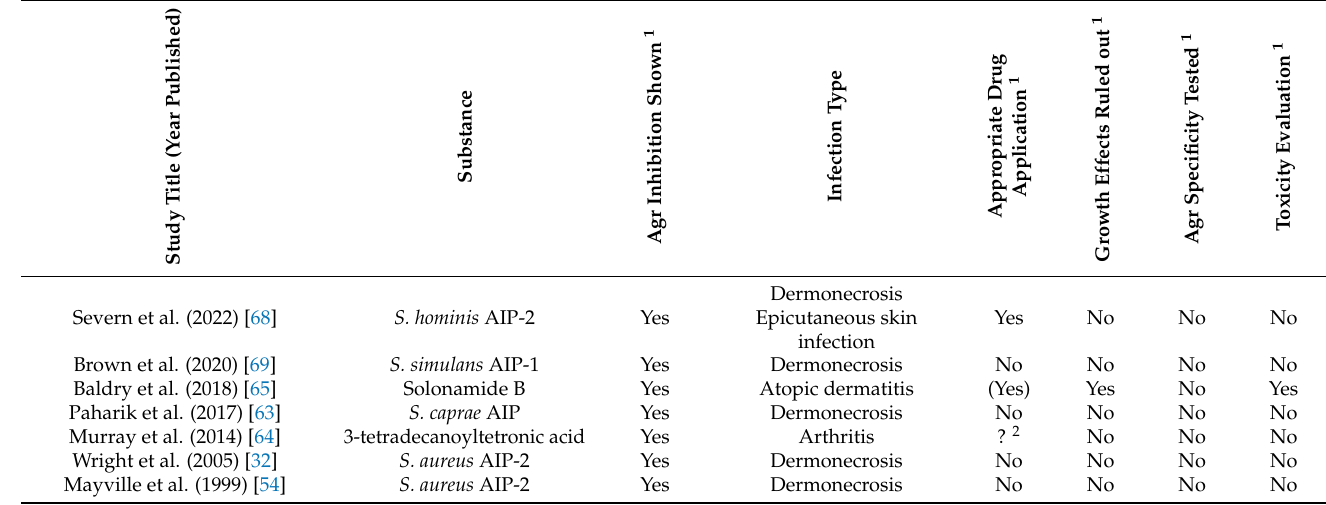
Table 1. In vivo studies with drugs targeting